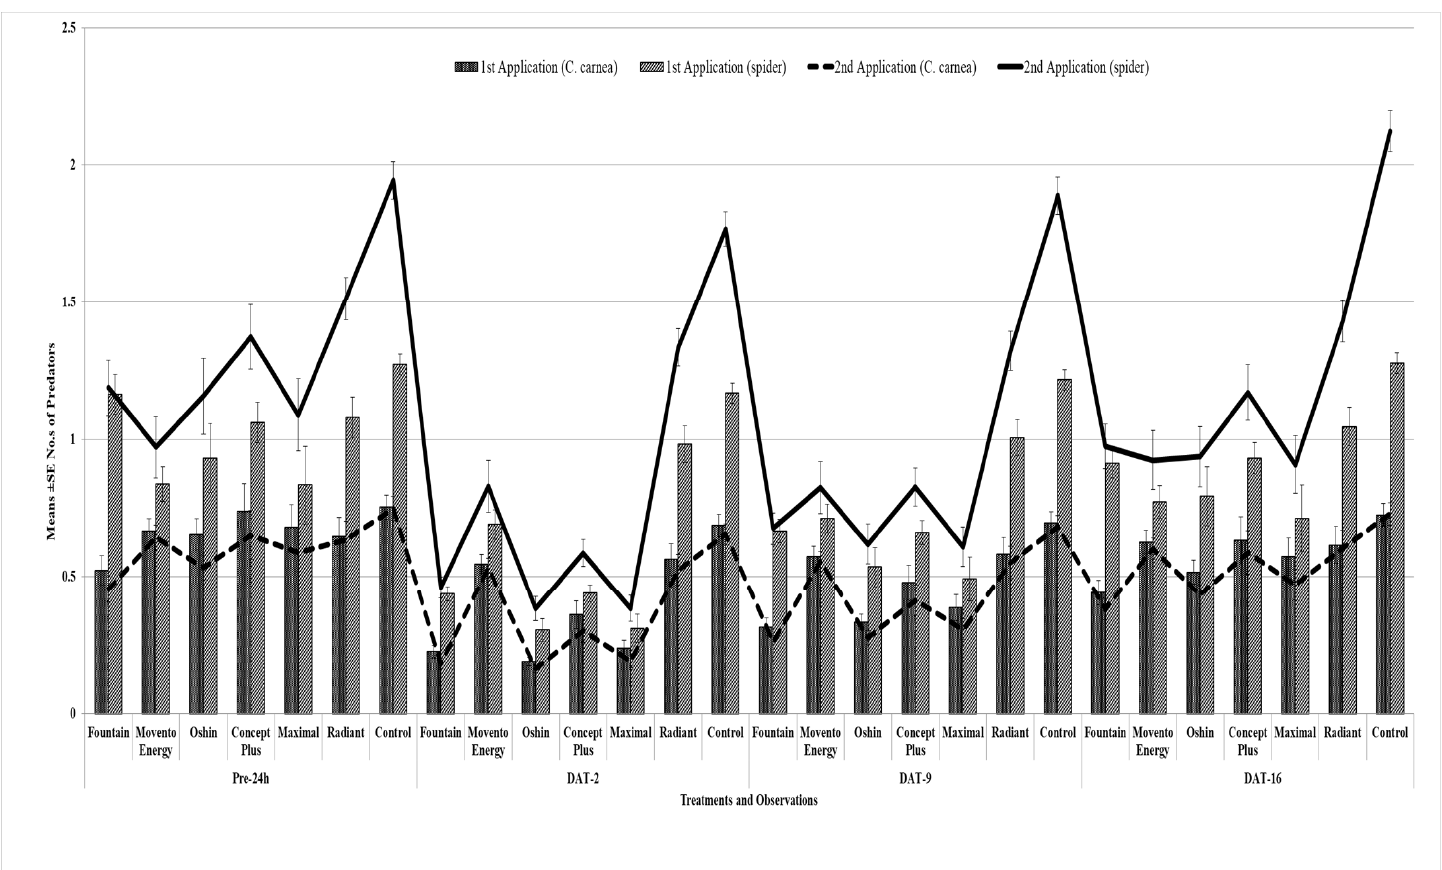
Figure 2. Effect of different insecticides on numbers of C. carnea and predatory spiders per plant. Mean (±SEM) in Bt cotton field plots on 26 June 2019 and 15 July 2019, observed at pre-24 h, 2 DAT, 9 DAT, and 16 DAT (days after Treatment).